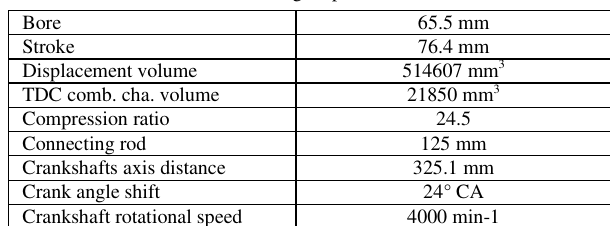
Table 1. Engine parameters